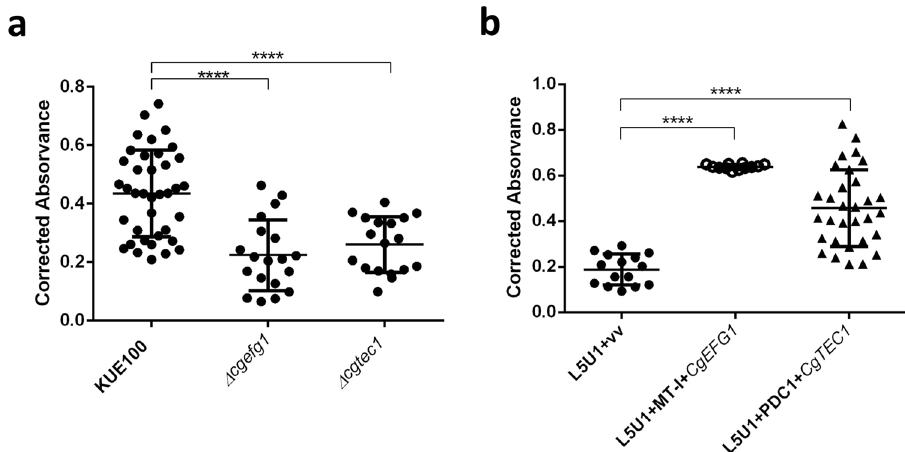
Fig. 4 CgEfg1 and CgTec1 are necessary for C. glabrata bio fi lm formation on polystyrene surface. Assessment of 24 h bio fi lm formation was performed by Presto Blue Cell Viability Assay in microtiter plates of: a C. glabrata wild-type KUE100 and deletion mutant Δ cgefg1 strains harboring the pGREG576 cloning vector (vv), or the pGREG576_MT-I_ CgEFG1 (CgEFG1) plasmid, and b C. glabrata wild-type KUE100 and deletion mutant Δ cgtec1 strains harboring the pGREG576 cloning vector (vv) or the pGREG576_PDC1_ CgTEC1 (CgTEC1) plasmid grown in SDB medium, pH 5.6. Values obtained are the average levels from at least three independent experiments. Error bars indicate SDs. **** P < 0.0001, n ≥